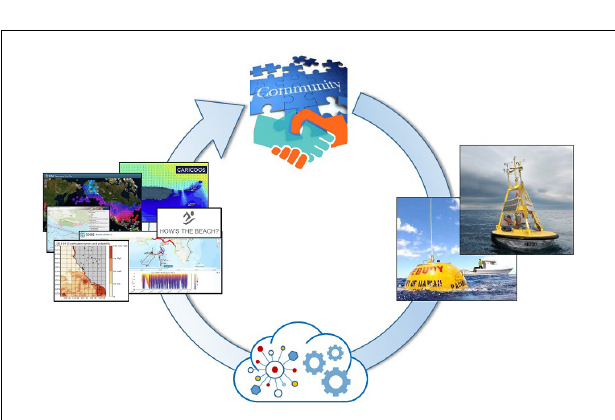
FIGURE 3 | The Structure of the Framework for Ocean Observing. Source: Lindstrom et al. (2012).